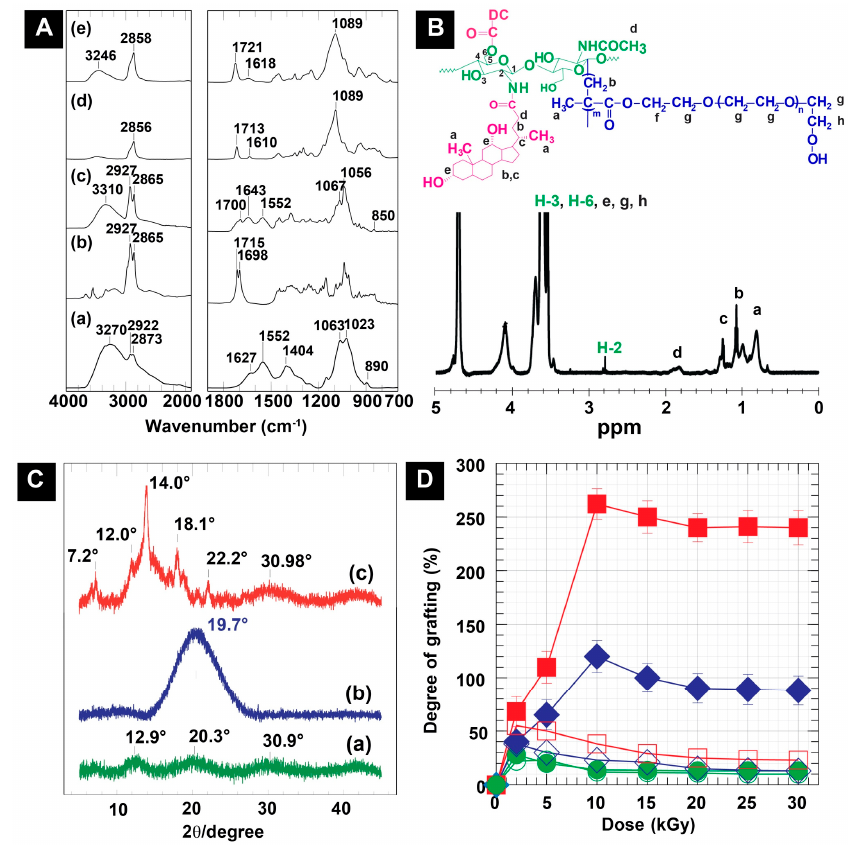
Figure 1. ( A ) FTIR spectra of ( a ) WCS, ( b ) DC, ( c ) DC-WCS, ( d ) PEGMA, and ( e ) DC-WCS-PG. ( B ) 1 H NMR spectra of DC-WCS-PG. ( C ) XRD patterns of ( a ) WCS, ( b ) DC-WCS, and ( c ) DC-WCS-PG.